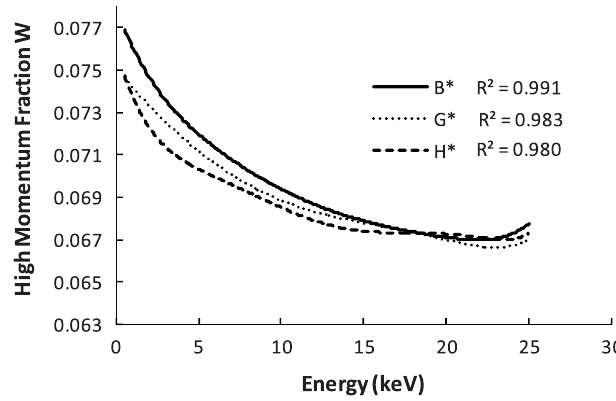
FIG. 12. High momentum annihilation fraction W vs positron energy for unbaked ( B (cid:7) ) and baked ( G (cid:7) , H (cid:7) ) FG